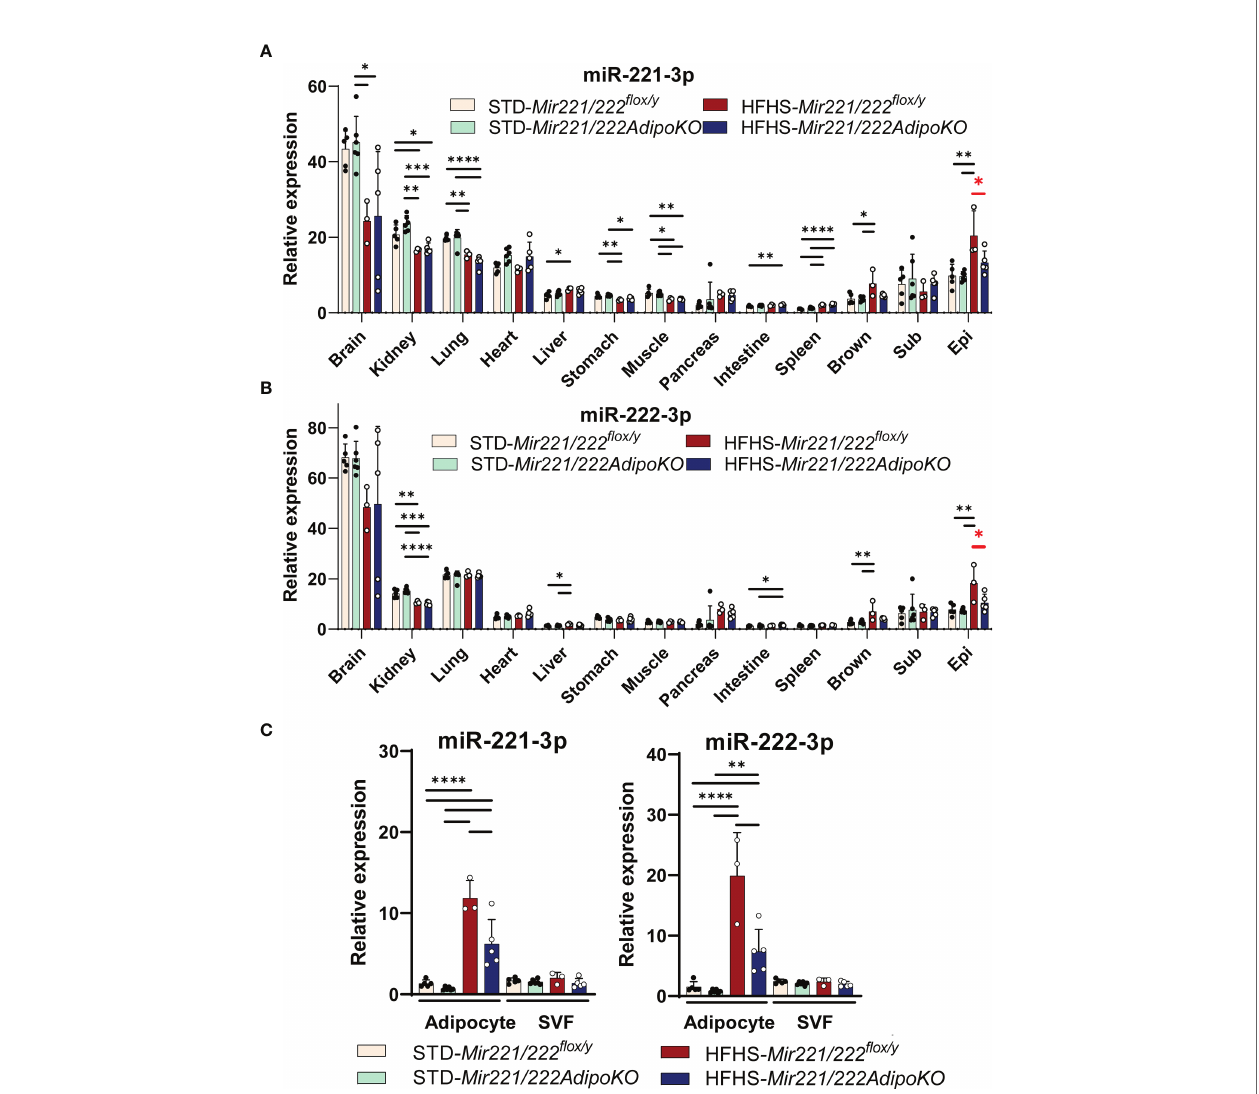
FIGURE 2 | Expression of Mir221 and Mir222 in Mir221/222 fl ox/y and Mir221/222AdipoKO male mice fed with high fat high sucrose (HFHS) or standard (STD) chow. (A, B) In various tissues, the expression of miR-221-3p and miR-222-3p is normalized by snoRNA202 and snoRNA234. The HFHS-induced up-regulation of miR- 221-3p and miR-222-3p in epididymal adipose tissues was reversed in Mir221/222AdipoKO (red asterisks). (Epi, epididymal; Mes, mesenteric; Sub, inguinal; Brown, Brown adipose tissues) (C) Serum concentration of miR-221-3p and miR-222-3p. HFHS Mir221/222 fl ox/y (n=3), HFHS Mir221/222AdipoKO (n=5), STD Mir221/ 222 fl ox/y (n=5) and STD Mir221/222AdipoKO mice (n=6). Data shown as mean ± SD and analyzed by one-way ANOVA with Tukey test (*p<0.05; **p<0.01; ***p<0.001;